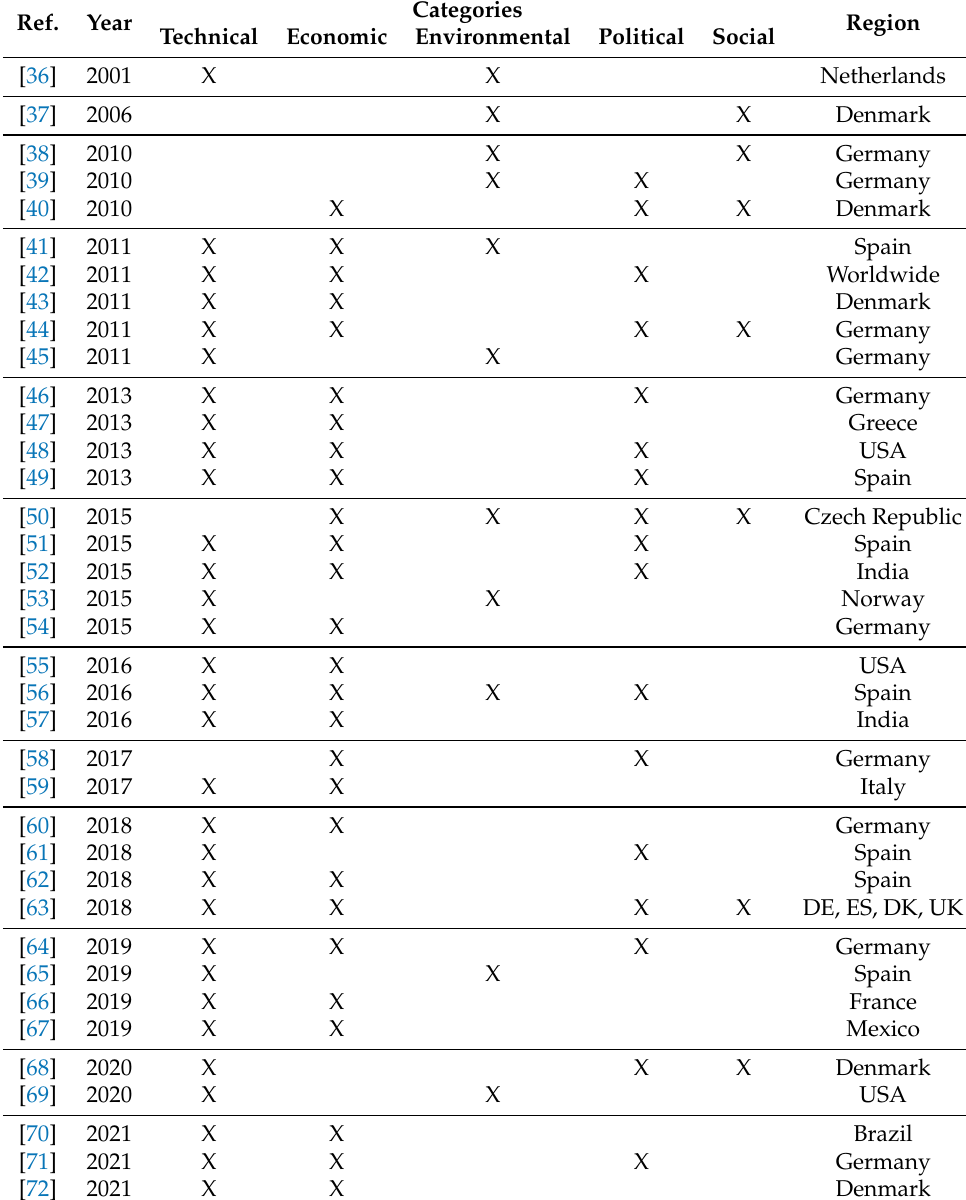
Table 2. Contributions with several categories in onshore wind repowering methodologies. Period (2000–2021).